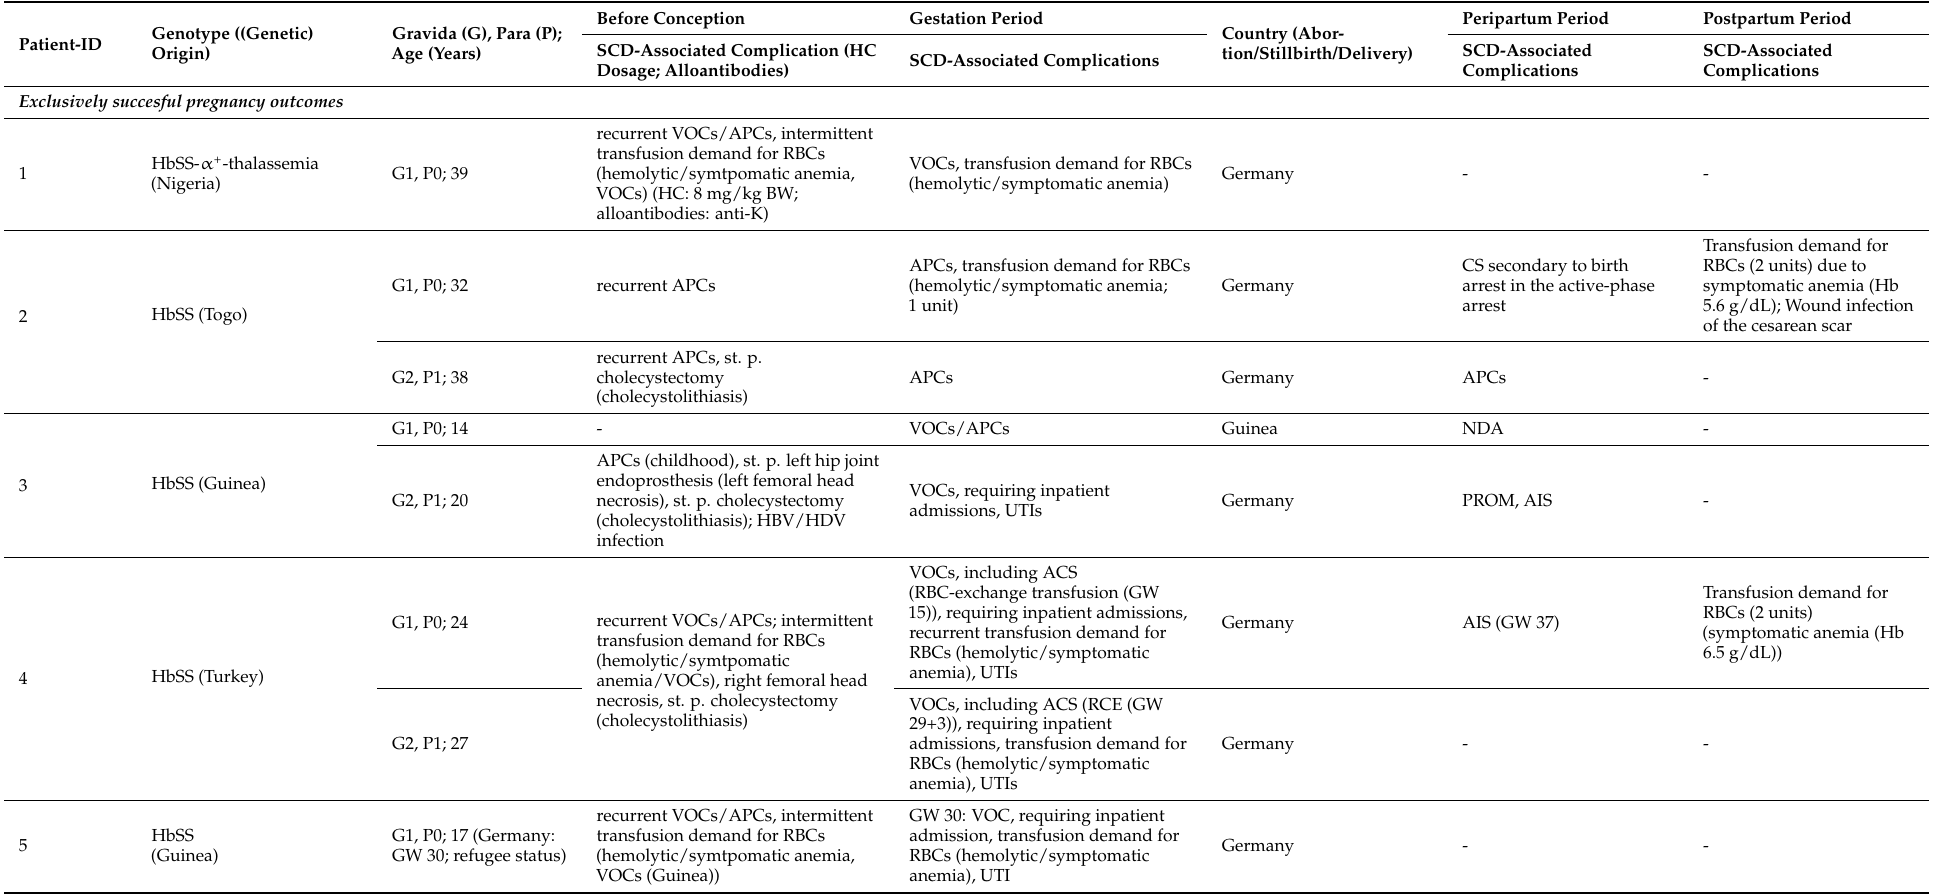
Table 1. Maternal characteristics, including antenatal, peri-, and postpartum complications in SCD patients (N =